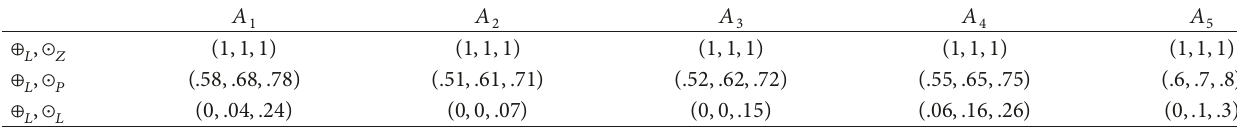
Table 5: Fuzzy global scores for each strategy.